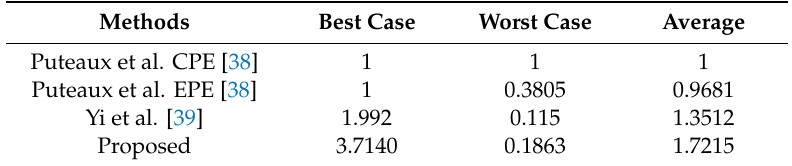
Table 5. Maximum embedding rate comparison between the proposed method and methods [38,39] on the BOW-2 database (bpp, 10,000